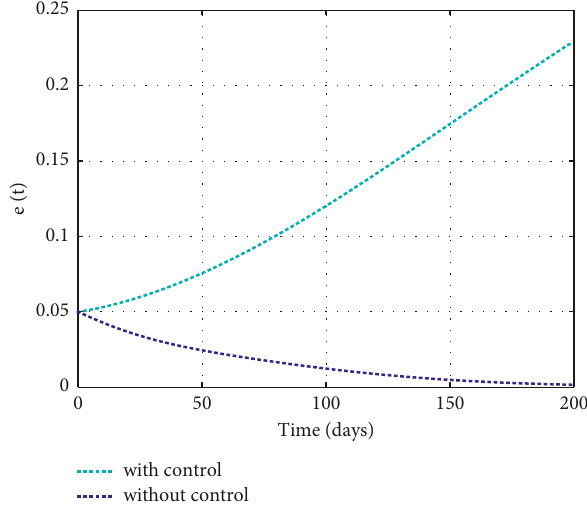
Figure 10: Simulation of cholera recovered HIV